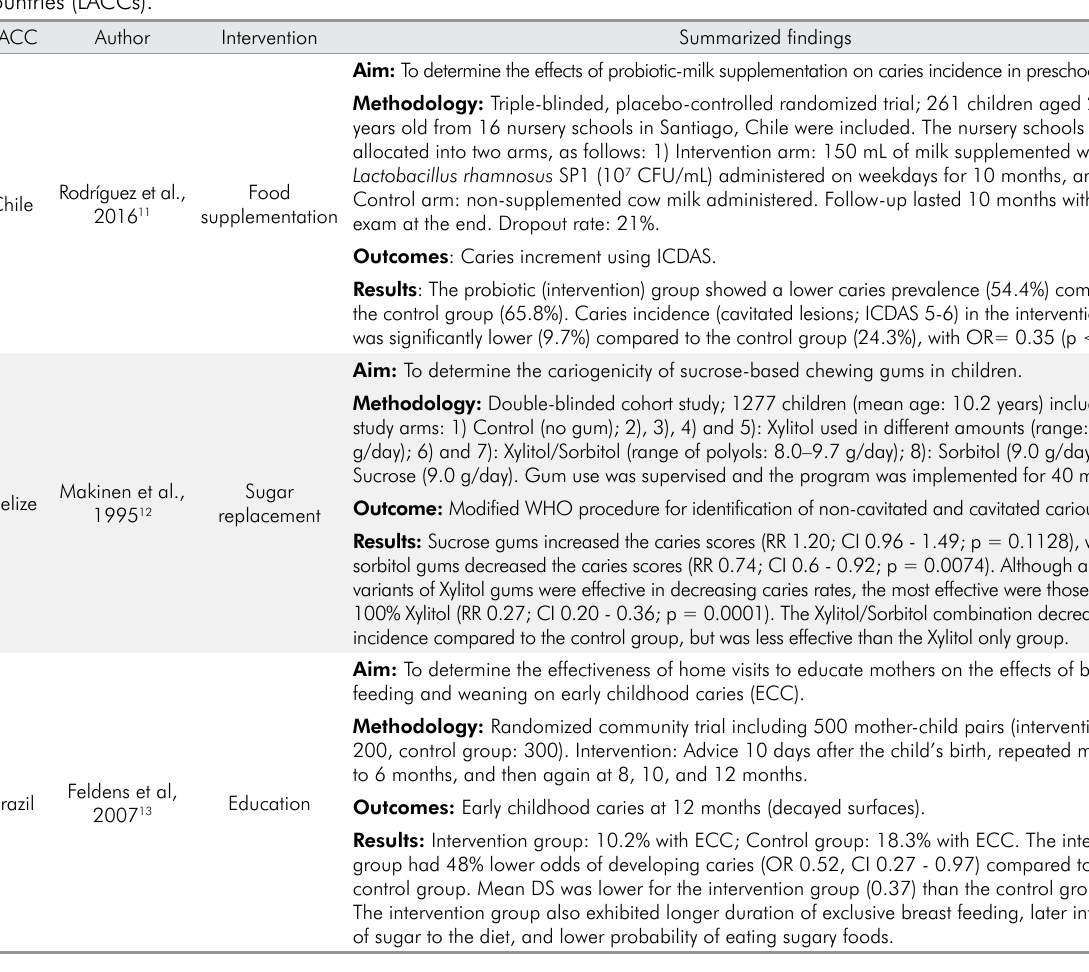
Table 1. Interventions based on restriction of sugar consumption for dental caries control in Latin American and Caribbean countries